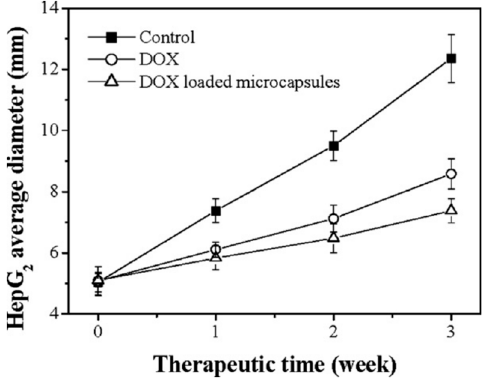
Figure 11. The diameter of HepG2 BALB/c/nu tumors measured over the three-week period via use of encapsulated and free DOX treatments. The capsules utilized are CS/ALG-based, templated from CMC-doped CaCO 3 crystals. Figure taken with permission from Reference [82], copyright © 2007, Elsevier.